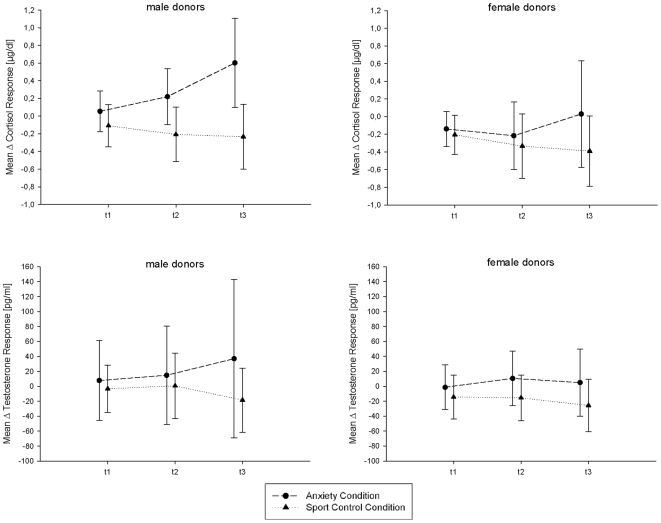
Cortisol (top) and testosterone (bottom) change-scores (difference values compared to the baseline measurement: means, SDs) for male (left) and female (right) donors at the three time points (t1, t2, and t3, separated by 30 min each).